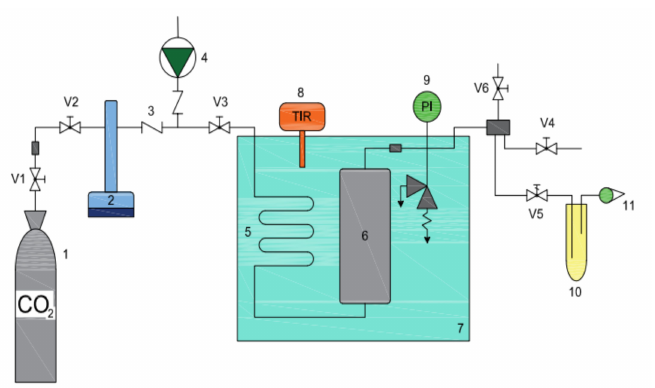
Figure 11. Schematic diagram of the high-pressure extraction apparatus (1—gas tank, 2—high pressure pump, 3—check valve, 4—HPLC pump, 5—gas heating tube, 6—autoclave, 7—water tank with heater, 8—temperature regulator, 9—manometer pressure gauge, 10—extract, 11—rotameter,